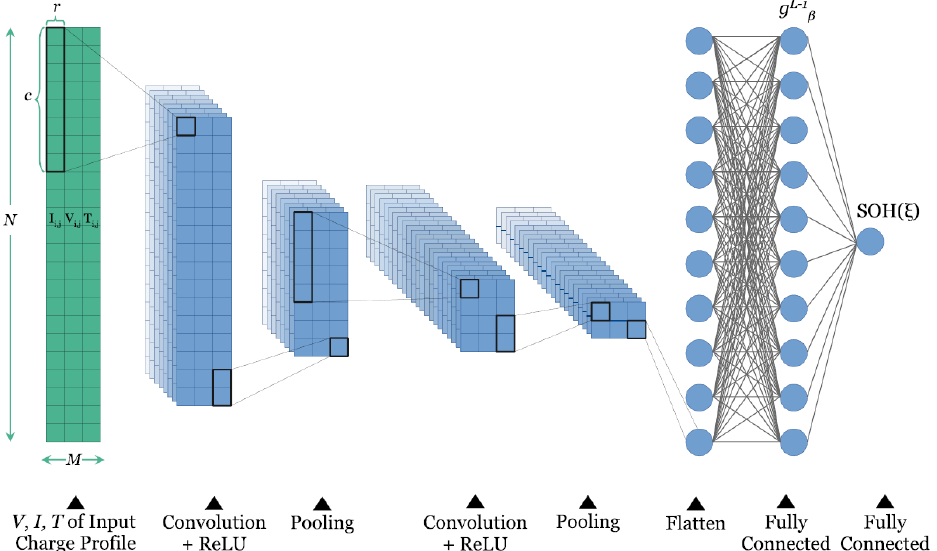
Figure 1. Architecture of a convolutional neural network (CNN) where each layer is composed of a convolution and pooling component and with the last two layers being fully connected. The input data is given by 𝛹(𝜉) ∈ ℝ 𝑁×𝑀 where N = 256 and M = 3 since 𝛹(𝜉) = [𝐼(𝜉); 𝑉(𝜉);𝑇(𝜉)] where I, V and T represent the current, voltage and temperature of the charge curve. The output of the CNN is the estimated SOH.